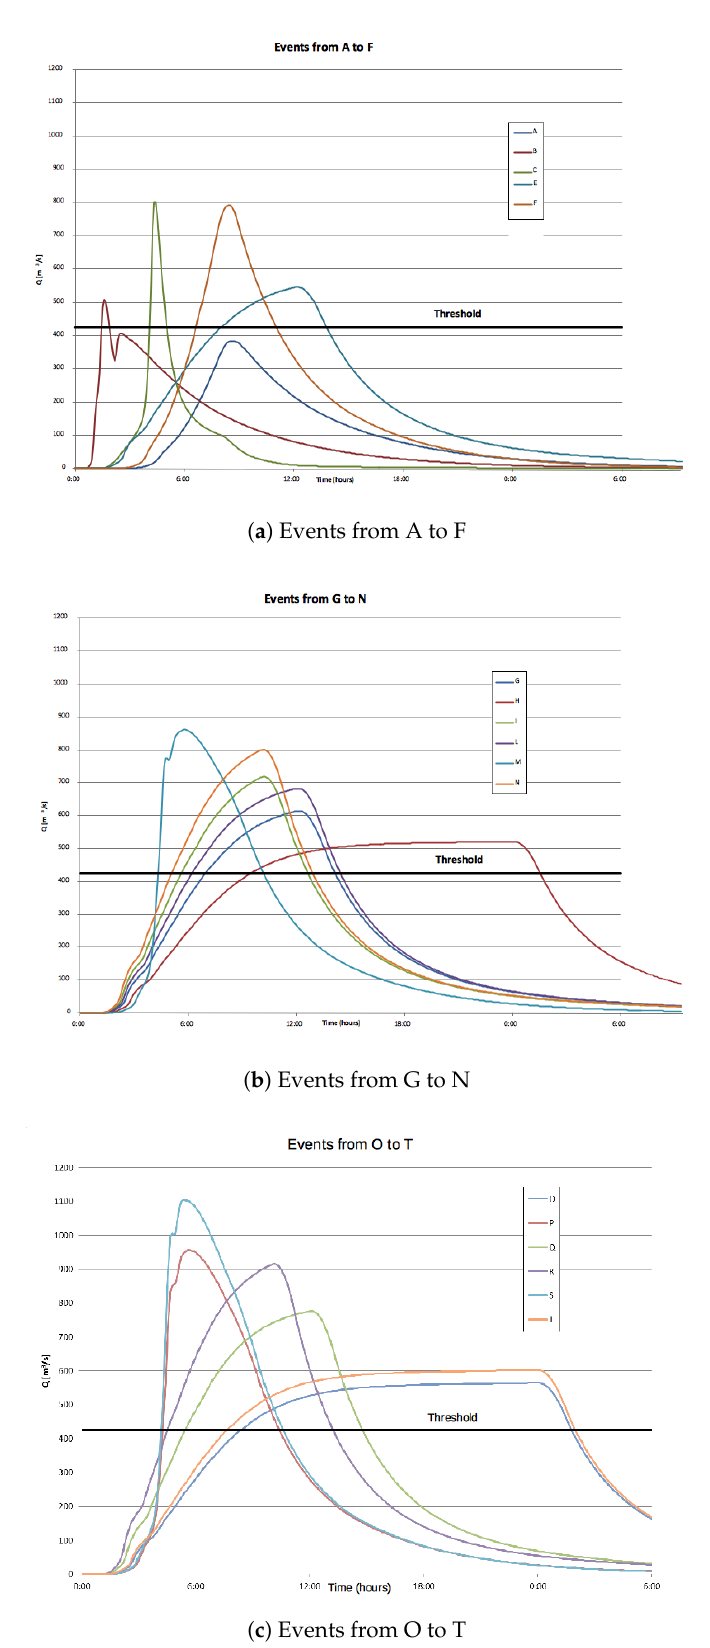
Figure 8. Hydrographs simulated by MIKE model in Corace watershed (Calabria, Italy) for n = 17 rainfall-runoff